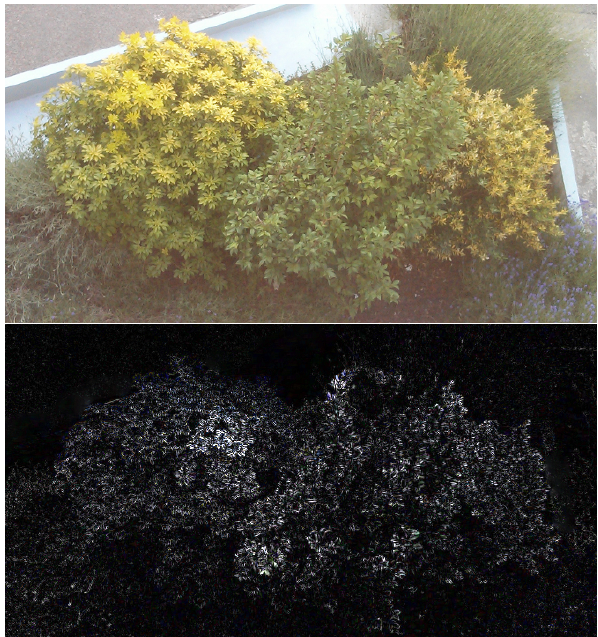
Figure 1: Top: image of small bushes taken from a fixed point of view. Bottom: the brightest areas show the biggest displacement of the vegetation during a period of one second.